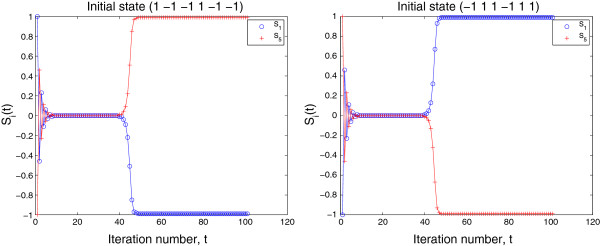
Projections of two trajectories onto two-dimensional (S1,S5)-subspace (Example 4). The trajectories initially converge towards 0 and then leave the divergent neighborhood of 0 and converge to one of the two saturated equilibrium expression states.